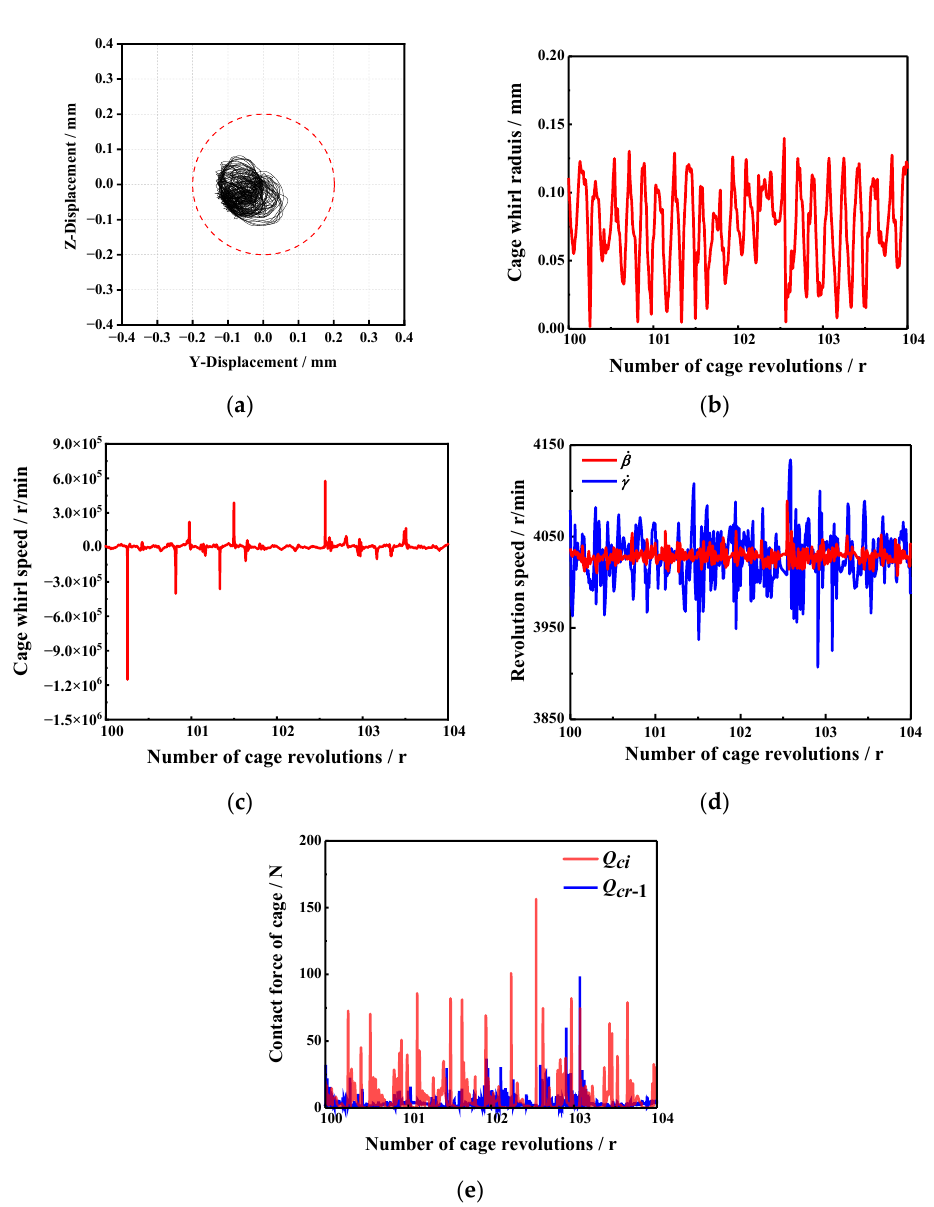
Figure 7. Whirl parameters and force of the cage under operating condition 1: ( a ) whirl orbit; ( b ) whirl radius; ( c ) whirl speed; ( d ) rotational speed of rollers and cage; ( e ) force on cage.